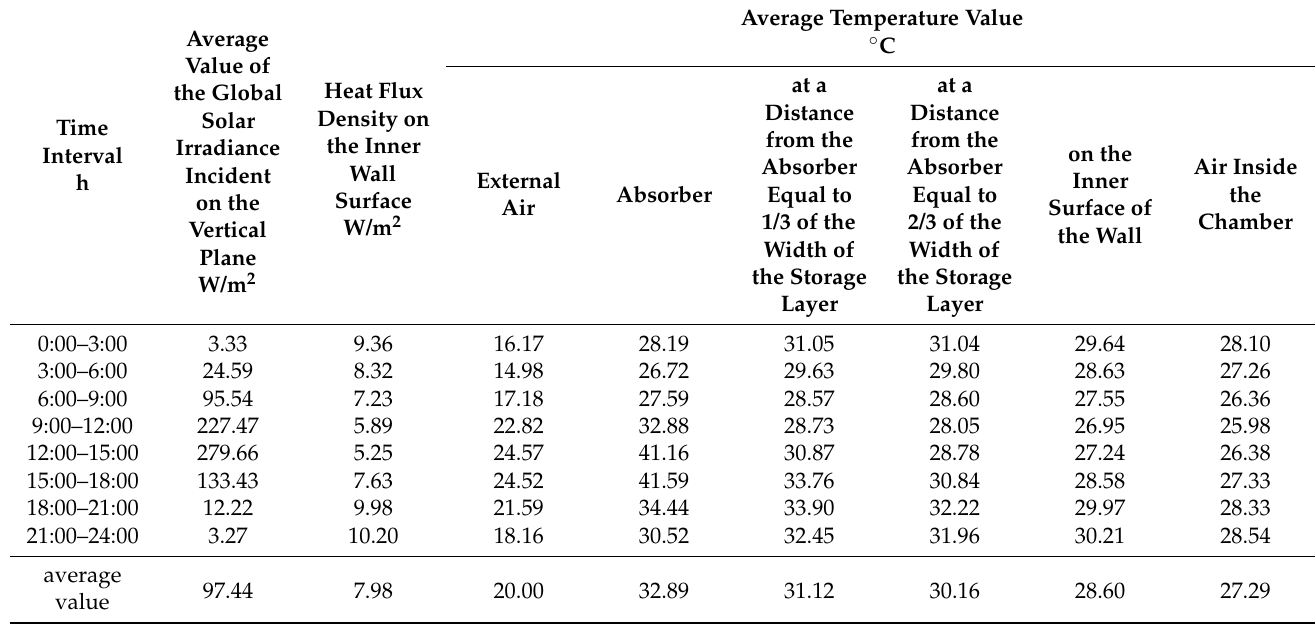
Table 2. Summary of the results of the tests carried out in June.